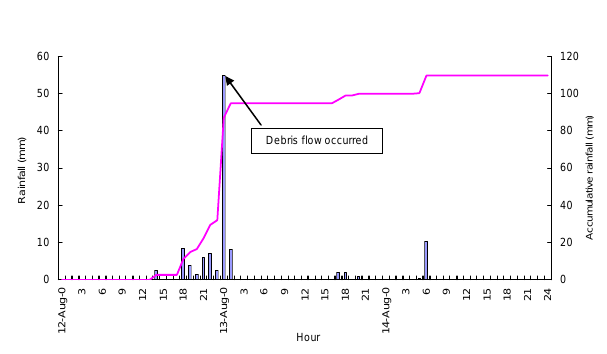
Fig. 2. Distribution of hourly and cumulative precipitation between August 12 and 14, 2010 in Qingping Town.